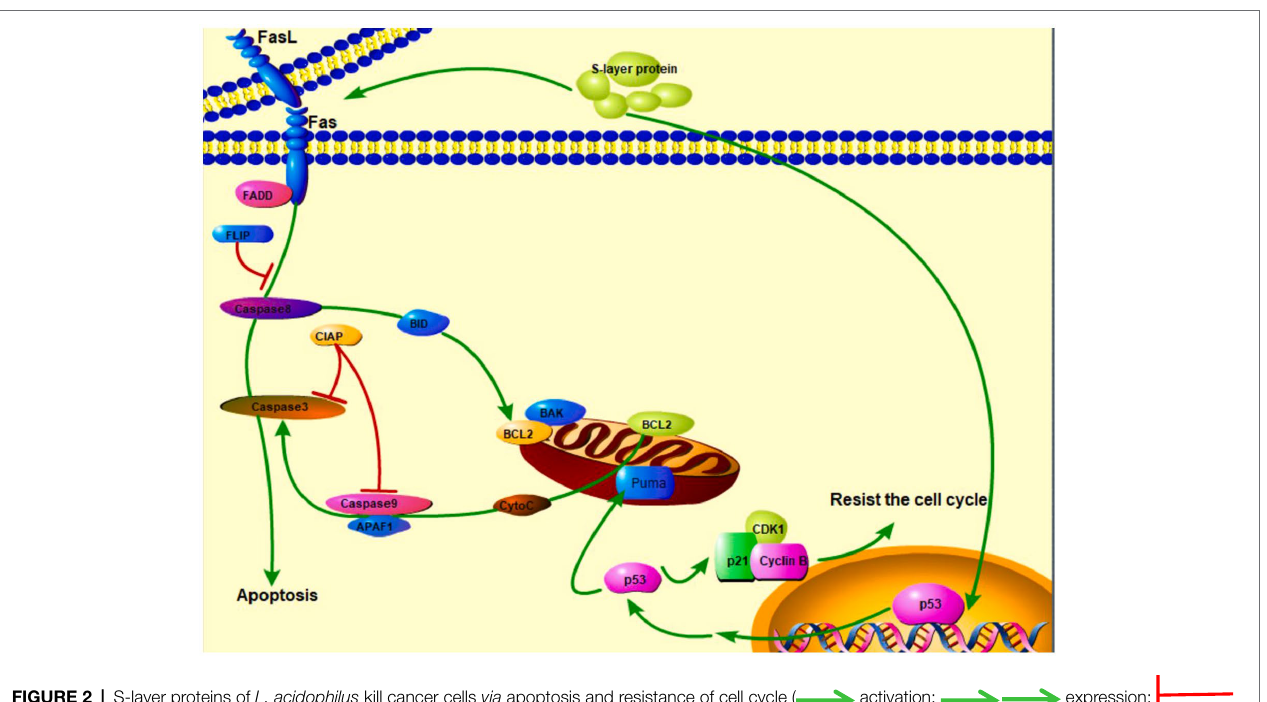
FIGURE 2 | S-layer proteins of L. acidophilus kill cancer cells via apoptosis and resistance of cell cycle ( activation; expression;